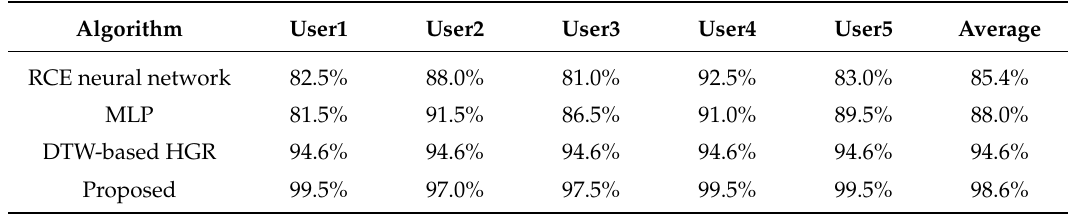
Table 3. Recognition performance of the proposed algorithm and